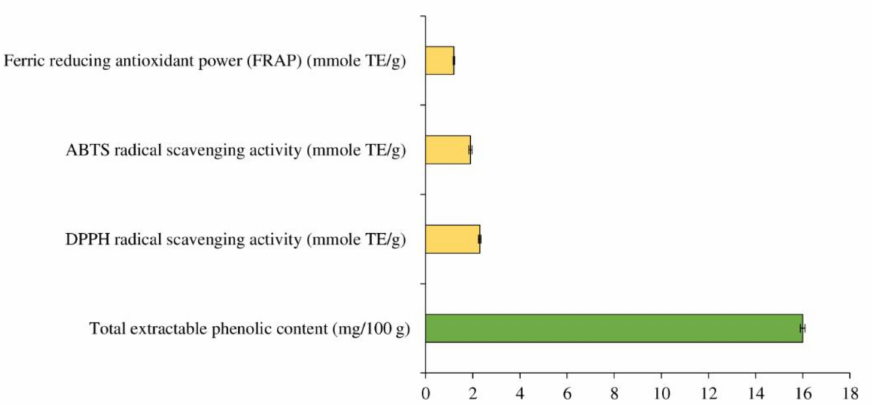
Figure 2. Total extractable phenolic content, DPPH radical scavenging activity, ABTS radical scaveng- ing activity, and ferric reducing antioxidant power (FRAP) of Mon-Pu leaf extract (MPE). TE = Trolox equivalent. Bars represent the standard deviations from triplicate determinations. Different letters indicate the significant differences ( p <